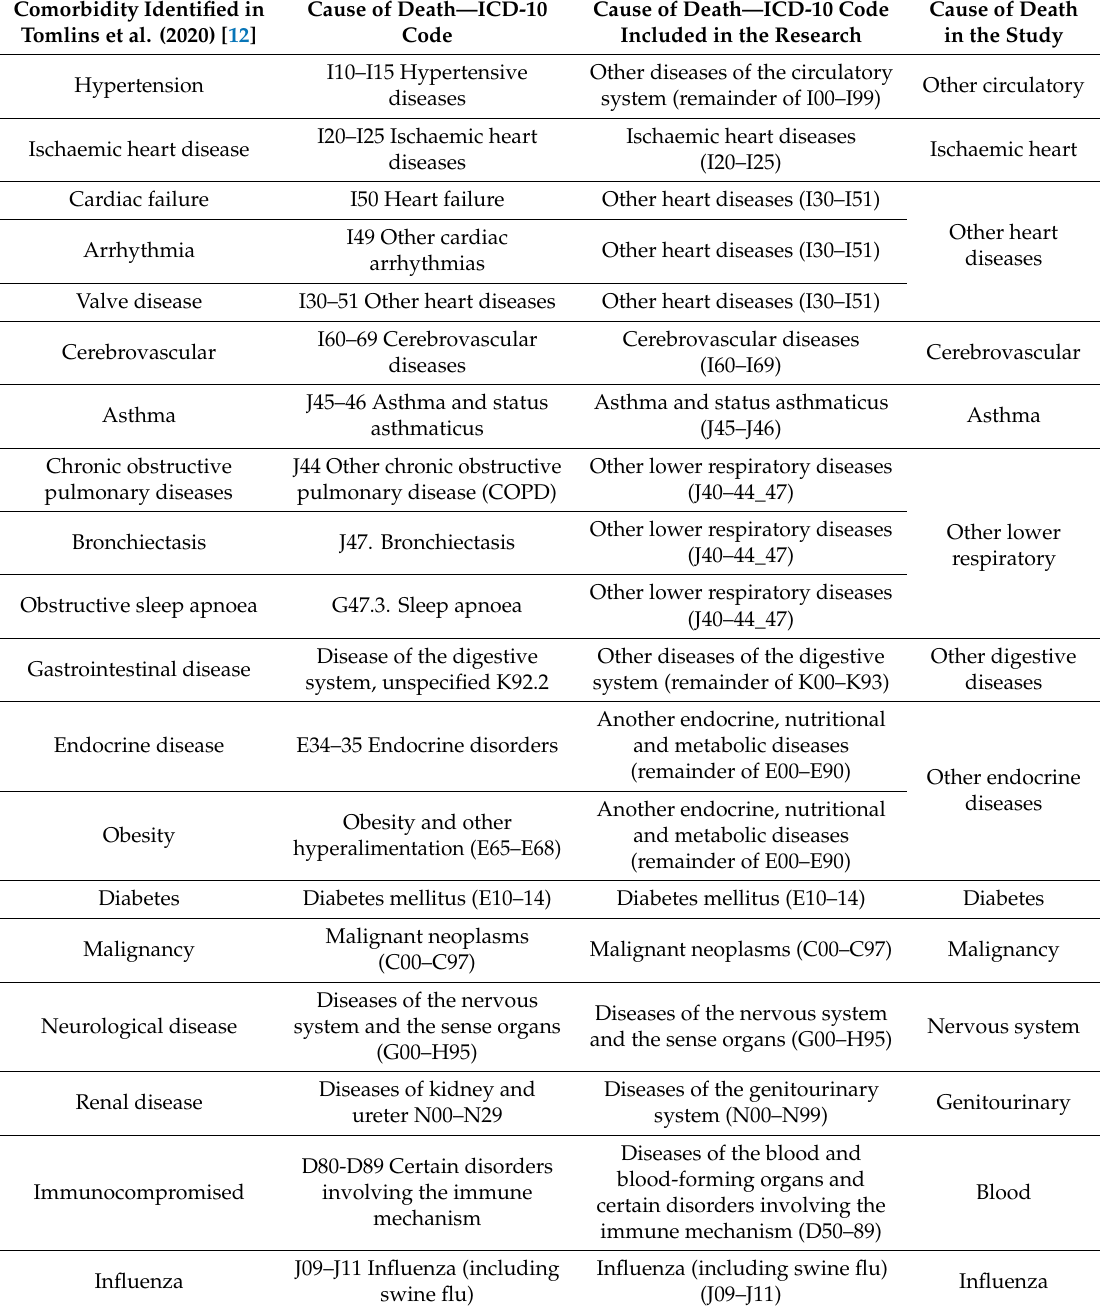
Table 1. Comorbidities and causes of death used in the